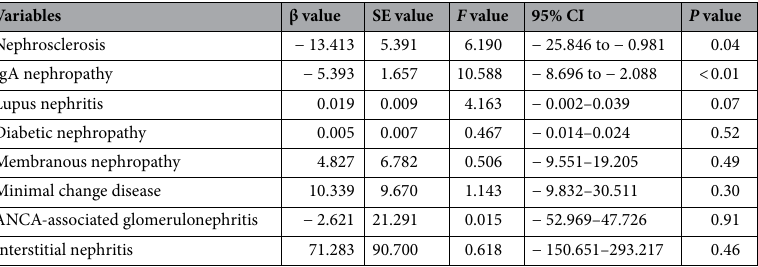
Table 4. Multivariate analysis between the rate of change in estimated glomerular filtration rate and FIB-4 index in each renal pathology. SE standard error, CI confidential